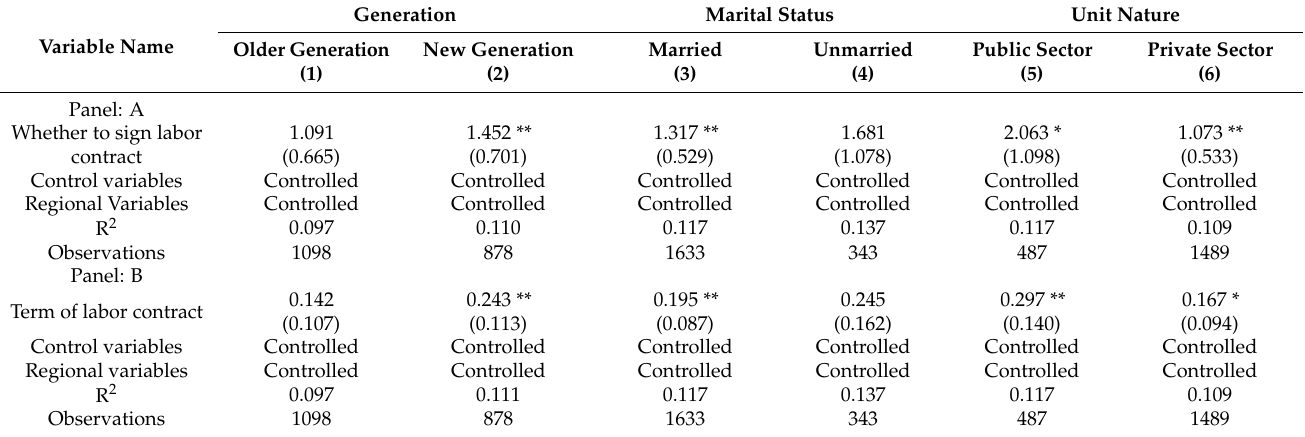
Table 7. Heterogeneous effects of the labor contract on the urban integration of migrant